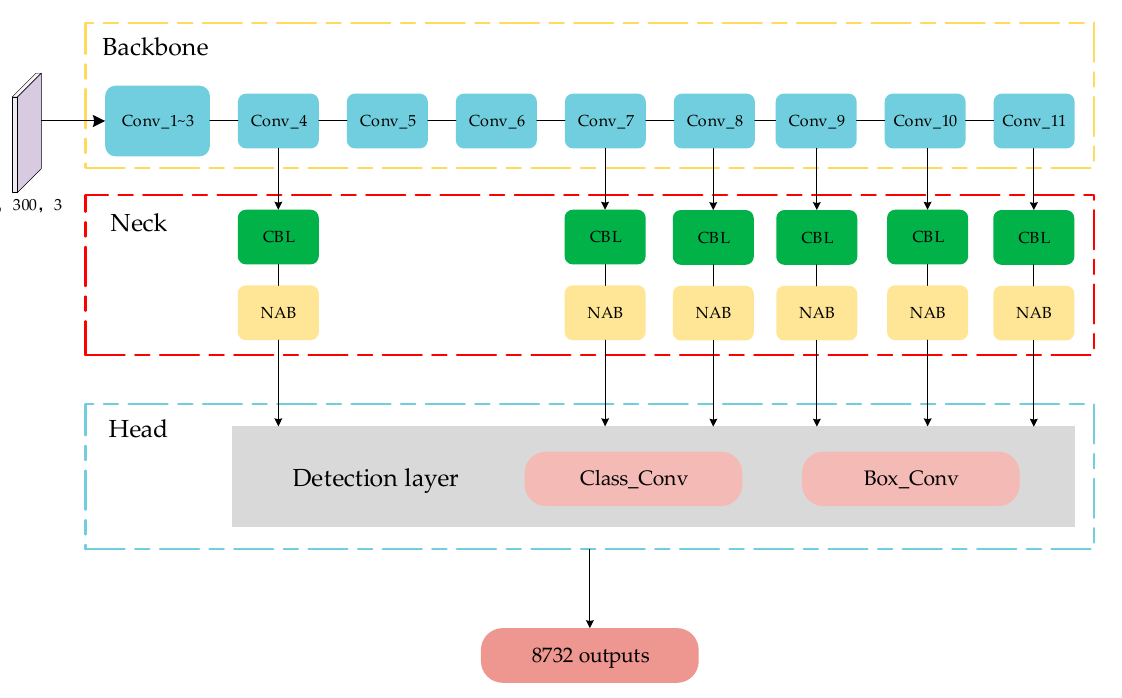
Figure 5. The network of the improved SSD. ‘Conv_1~3 ′ is the first three blocks of VGG16. For real-time detection, YOLOv4-Tiny, which has an excellent balance between accu- racy and speed, was modified with NAB. It is a simple version of YOLOv4 and has only about one-tenth of YOLOv4 ′ s parameters. YOLOv4-Tiny introduces the idea of CSPnet, which is the largest difference between it and YOLOv3. It only has two outputs for reducing the parameters. We improved it by inserting NAB into the neck, as shown in Figure 6. Because YOLOv4-Tiny has fewer channels than YOLOv3 and SSD, we did not append ‘CBL’ before NAB. By conducting experiments on various datasets, we found that the im- proved YOLOv4-Tiny has a more powerful capability in multi-scale object detection than the original one, though it increases computational complexity slightly.